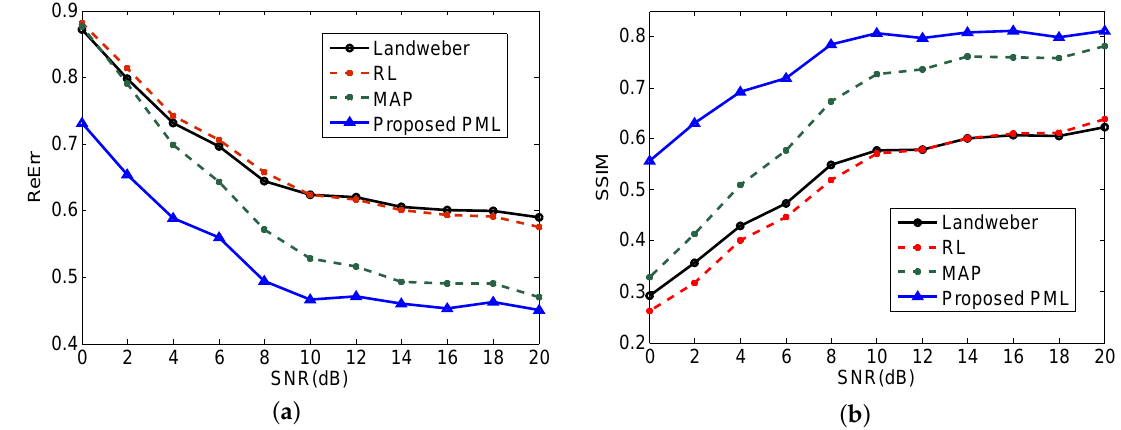
Figure 5. Quantitative comparison results of (a ) relative error (ReErr); ( b ) structure similarity (SSIM).